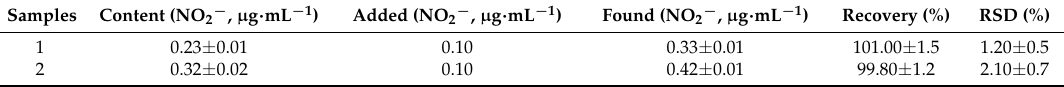
Table 1. Results of the detection of nitrite ions in river (1) and pond (2) water (n = 6). Samples Content (NO 2 − , µ g · mL − 1